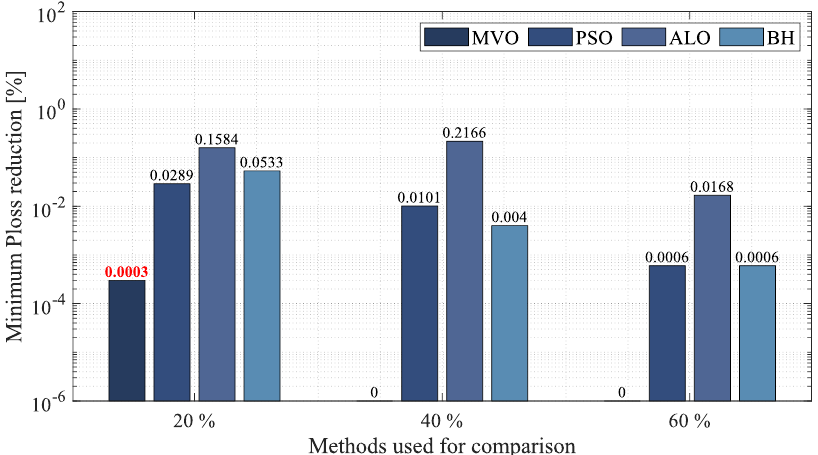
Figure 12. Percentage of reduction of minimum power losses obtained by the MVO in the 69-node radial system compared to other